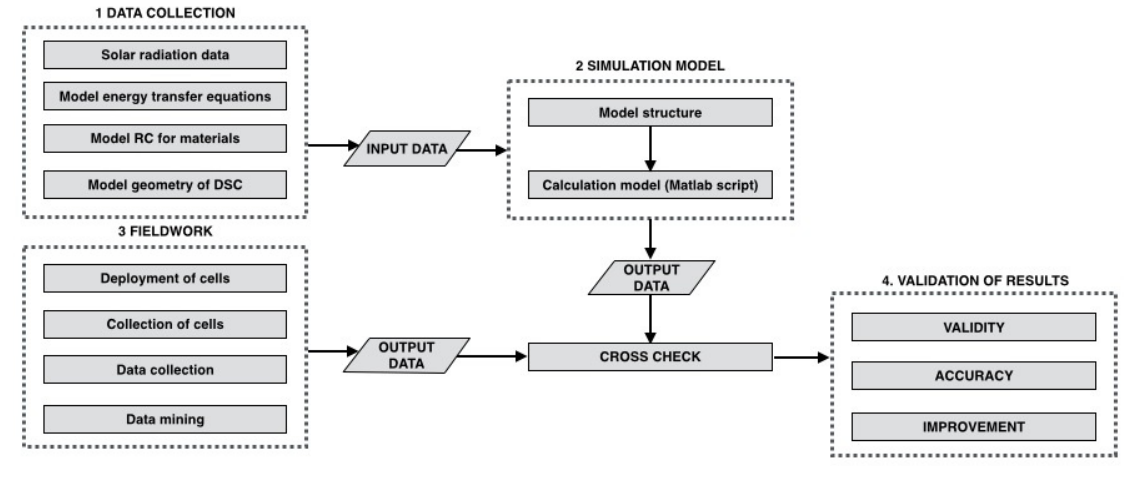
Figure 1. Decision Figure 1. Decision flowchart.